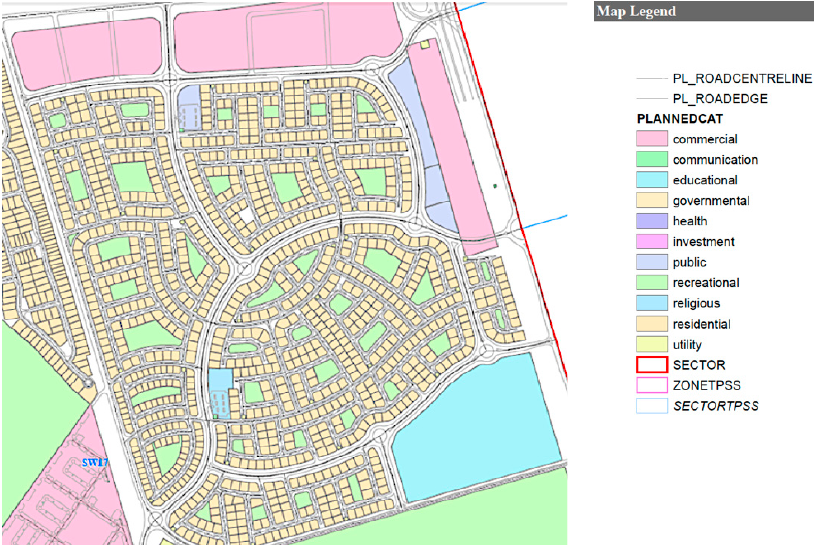
Figure 3. Watani Community in Abu Dhabi: land use plan (Source: ADM).